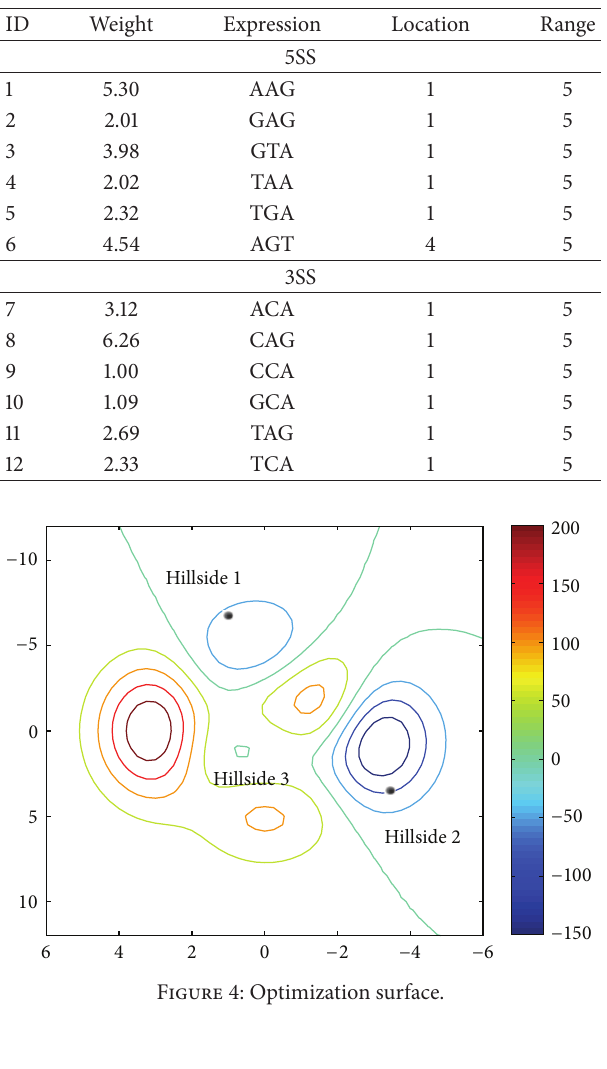
Table 2: MFPs of 5SS and